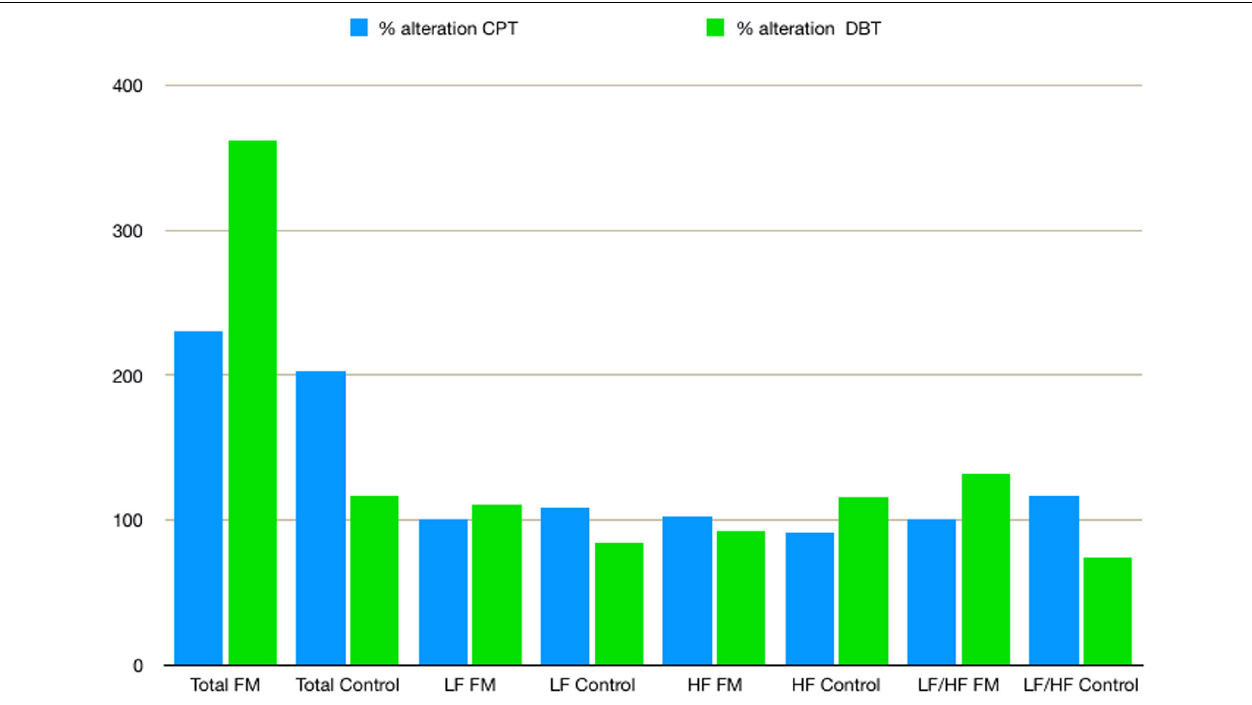
FIGURE 5 | The % alteration of frequency domain parameters of heart rate variability with respect to rest of respective parameter and study group. Data are expressed as % alteration of respective parameters and study group in comparison with rest. Control, control group; CPT, cold pressor test; DBT, deep breathing test; FM, fibromyalgia group; HF, high frequency; LF, low frequency; Total, total power.